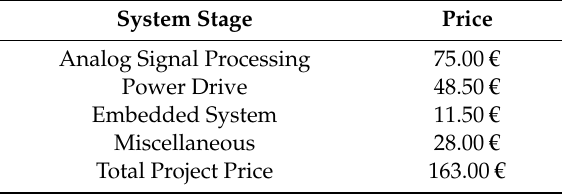
Table 3. Partial costs and total cost of the mAterials and components associated to the project.